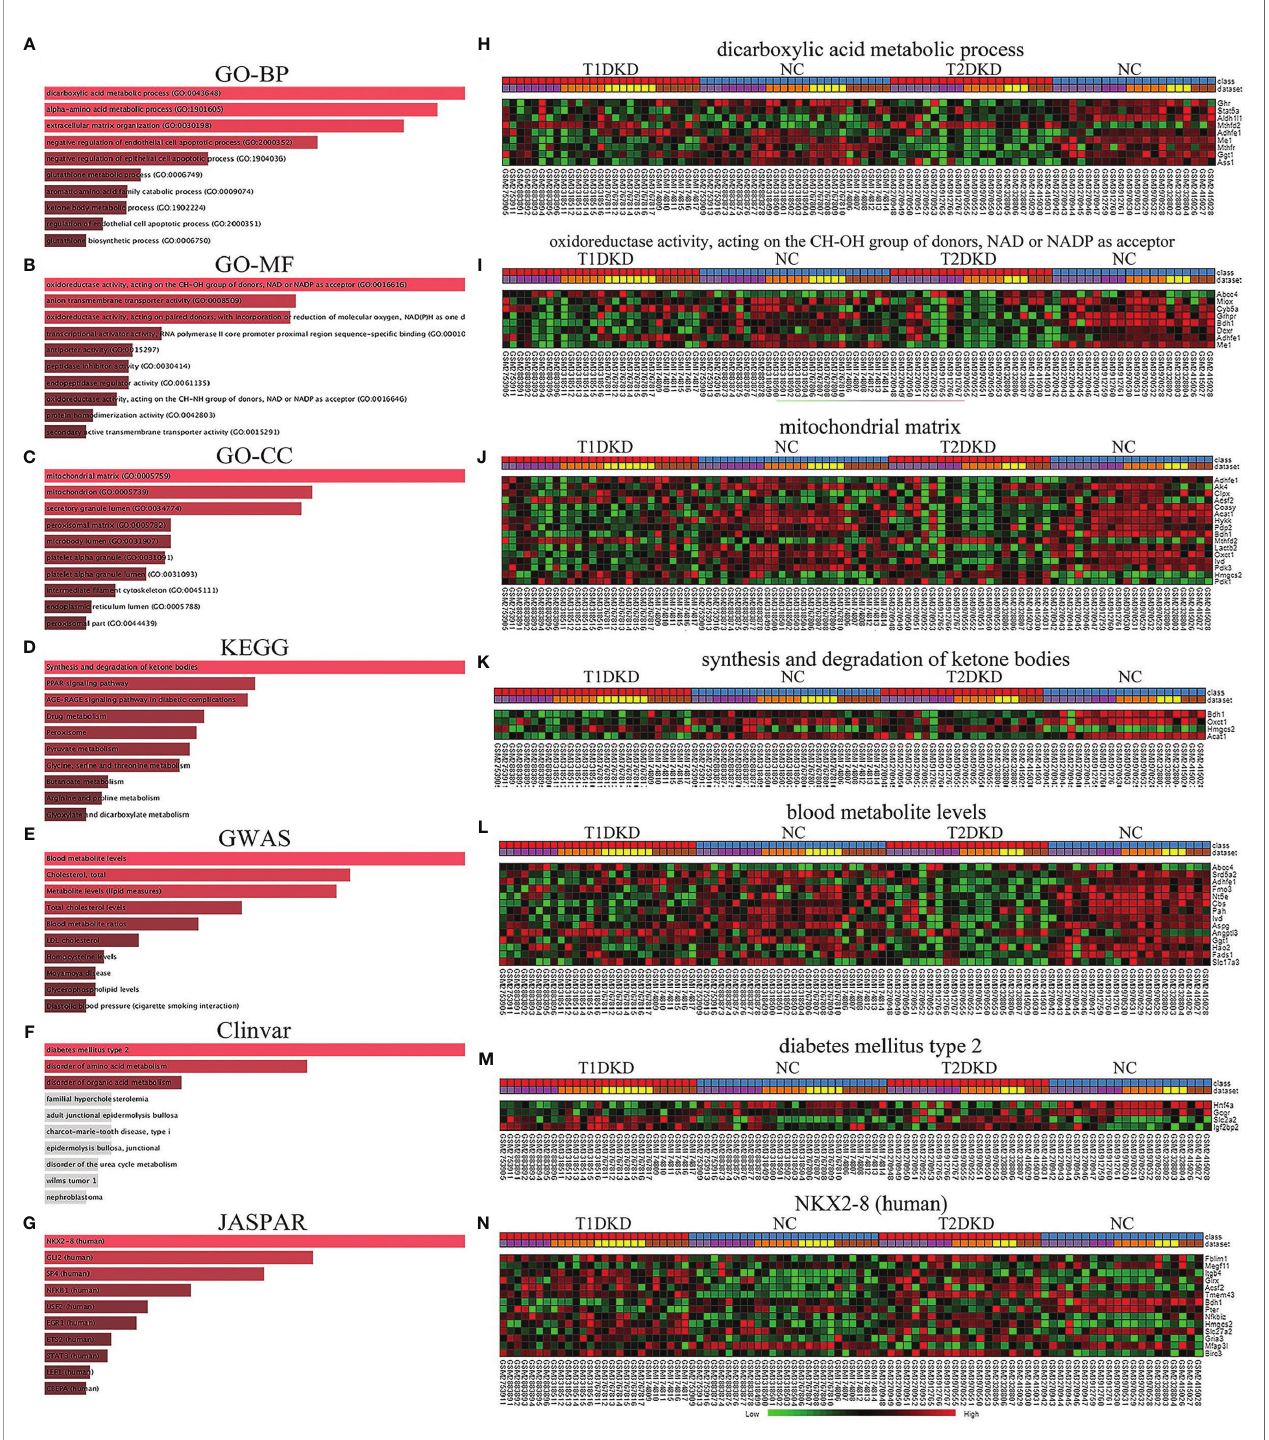
FIGURE 3 | Functional annotation and enrichment analysis of the shared DEGs in T1DKD and T2DKD datasets obtained by meta-analysis: (A-G) Functional annotation and enrichment analysis results in Enrichr. (A) GO-BP; (B) GO-MF; (C) GO-CC; (D) KEGG; (E) GWAS; (F) Clinvar; (G) JASPAR. (H – N) Heatmaps of genes enriched in each top1